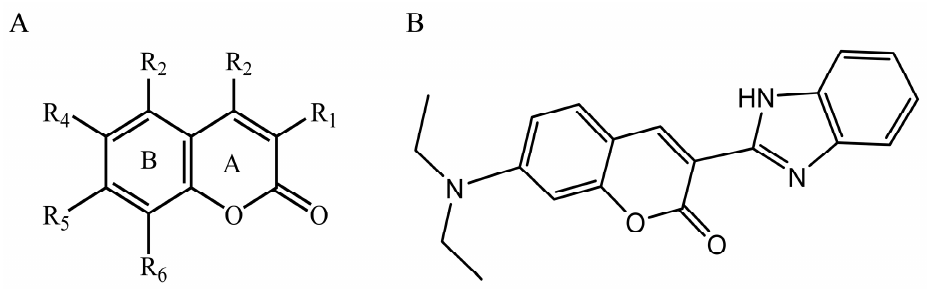
Figure 10. ( A ) Core structure of the test compounds and ( B ) the chemical structure of compound 2.